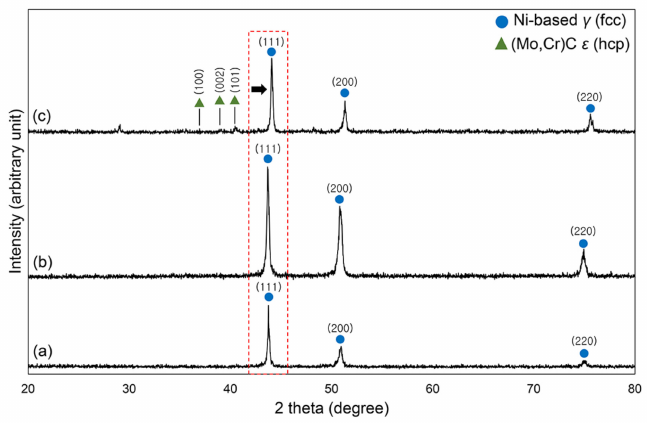
Figure 4. XRD spectra of Ni–Cr–Mo alloys: LWC ( a ), SLM ( b ), and SMM ( c ). Peaks corresponding to γ matrix and ε carbide phases were identified by ICDD card no. 03-065-6291 and 00-001-1188, respectively. Black arrow in SMM alloy ( c ) indicates shift of (111) plane.